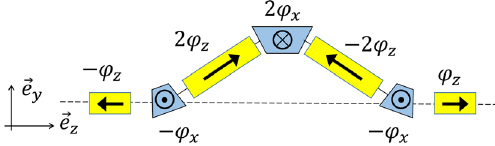
Fig. 3 SN with a vertical orbit bump for control of the vertical spin